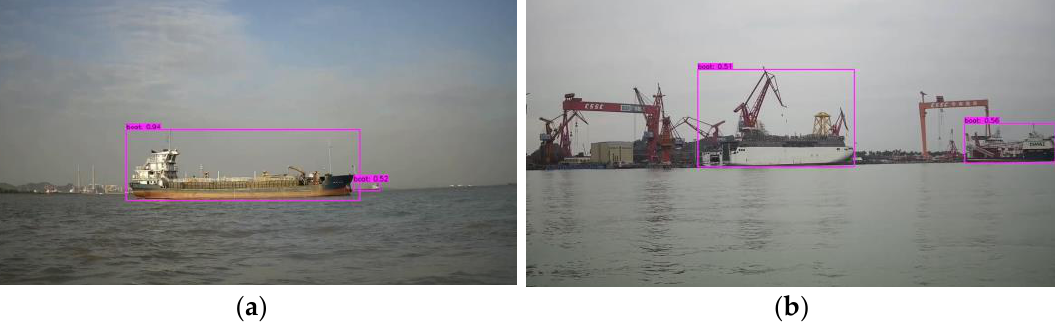
Figure 7. Target detection results with background interference in actual scenes. ( a ) Ship target detection under the interference of coastal buildings. ( b ) Ship target detection under the interference of shore equipment.